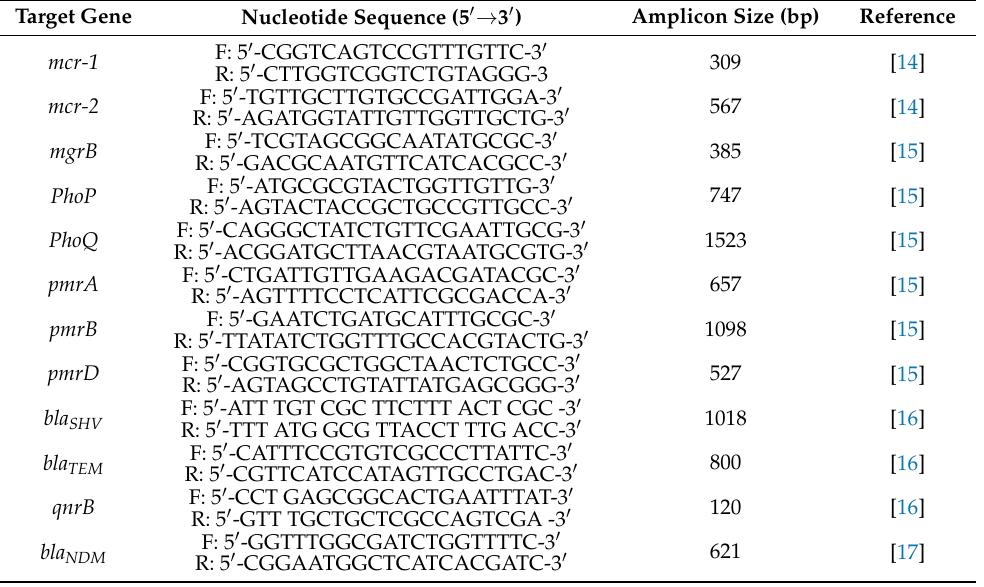
Table 1. List of primer pairs used for PCR amplification of the selected genes in this study. Target